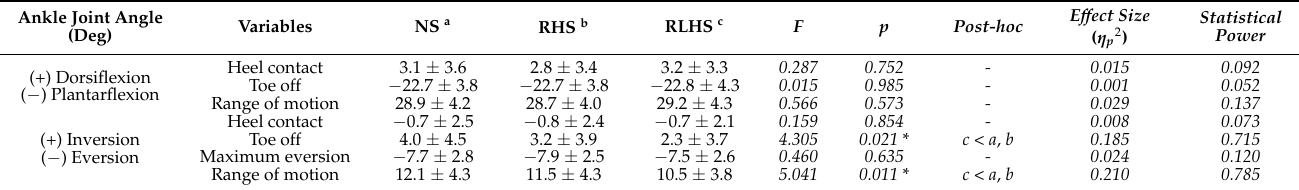
Table A2. Descriptive information for ankle joint angle during the stance phase of running.